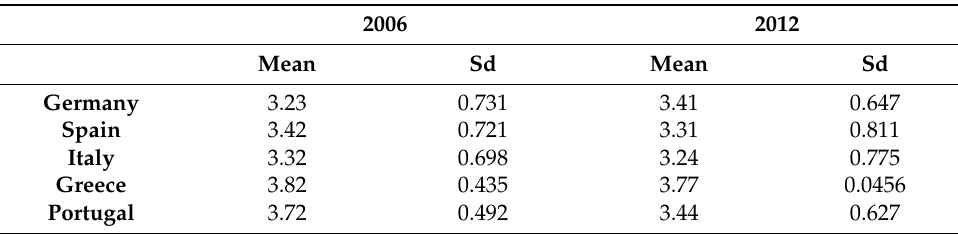
Figure 4. Percentages of citizens who feel very attached to the nation before and after the Great Recession. Authors’ own elaboration from EB 65.2 (2006) and EB 77.3 (2012). Table 1. Mean attachment among Germany, Spain, Italy, Greece, and Portugal before and after the Great Recession. Authors’ own elaboration from EB 65.2 (2006) and EB 77.3 (2012).